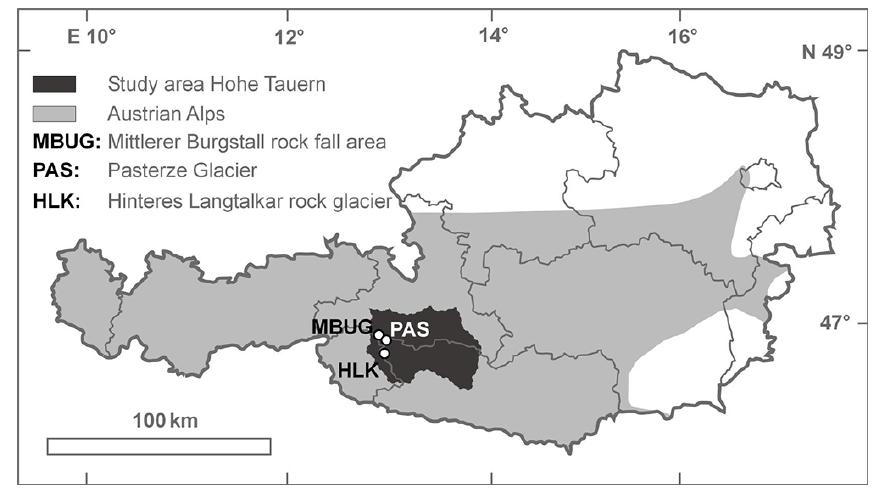
Figure 3. Study areas: the Pasterze Glacier, Hinteres Langtalkar rock glacier and Mittlerer Burgstall rockfall area within